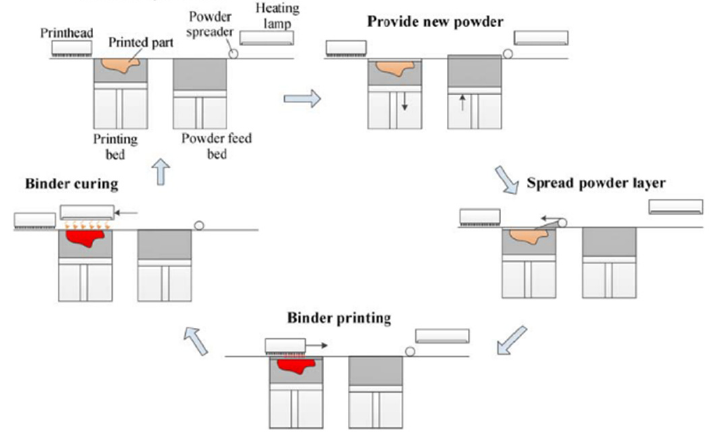
Figure 4. The schematics of BJ-AM process steps. Reproduced with permission from [86], Springer Nature, 2018.